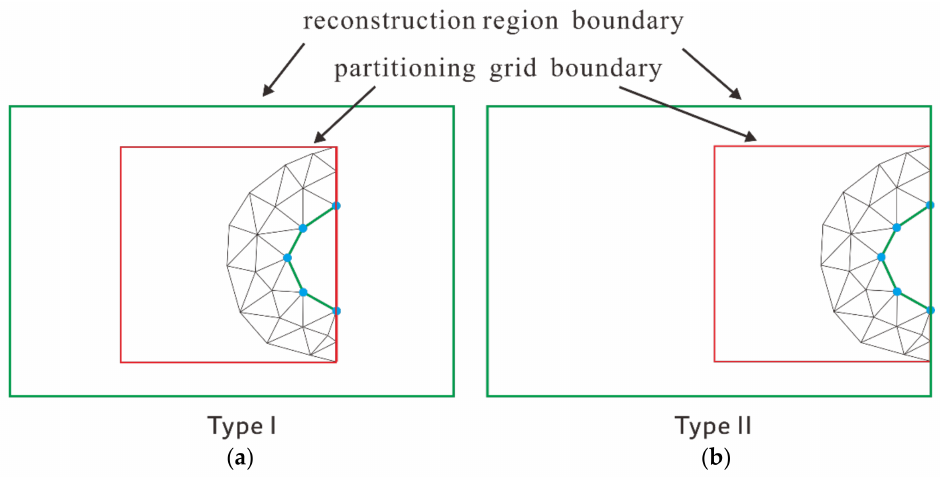
Figure 4. Initial classification of open holes: ( a ) internal open holes; ( b ) external open holes. The open holes are then further divided into four types according to their morpholog- ical